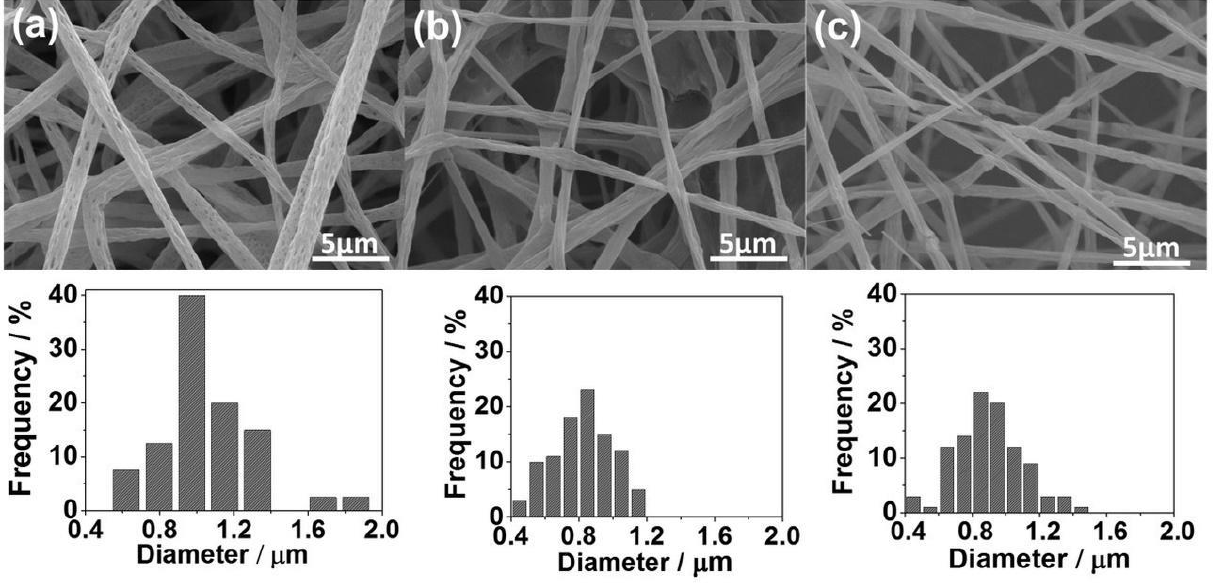
Figure 7. SEM images and fiber diameter histograms of PLA:SiO 2 membranes: ( a ) pure PLA, ( b ) SGSil, and ( c ) RHSil.